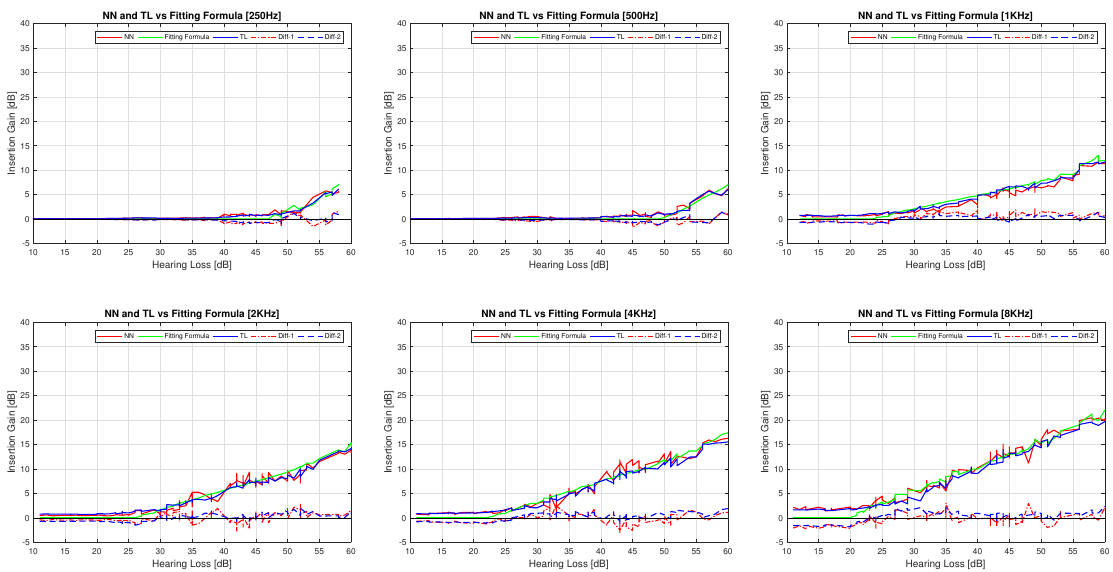
Figure 12. NAL-NL2: Performance comparison for NN and TL vs. fitting formula for the 80 dB input level. Comparisons are made for 250 Hz, 500 Hz, 1 KHz, 2 KHz, 4 KHz, and 8 KHz frequencies from top left to right to bottom left to right.